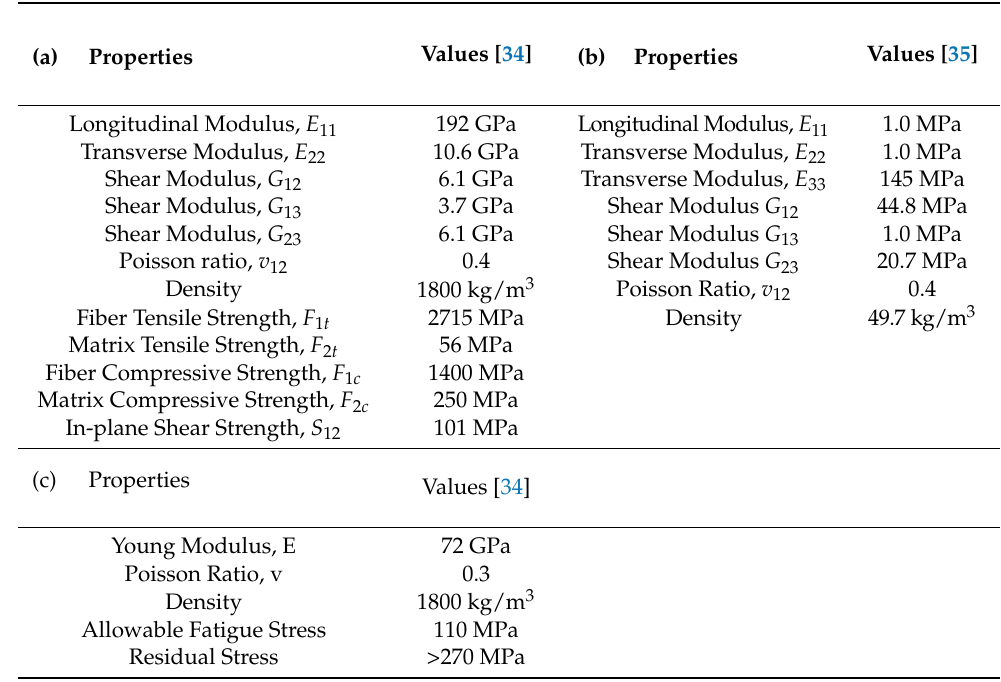
Table 1. Material properties of honeycomb sandwich core spoiler. (a) Unidirectional carbon